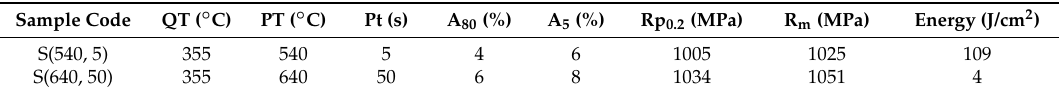
Table 2. Mechanical properties of samples Q&P treated immediately after laser welding. (Energy = Absorbed energy during Charpy V test at 20 °C.)